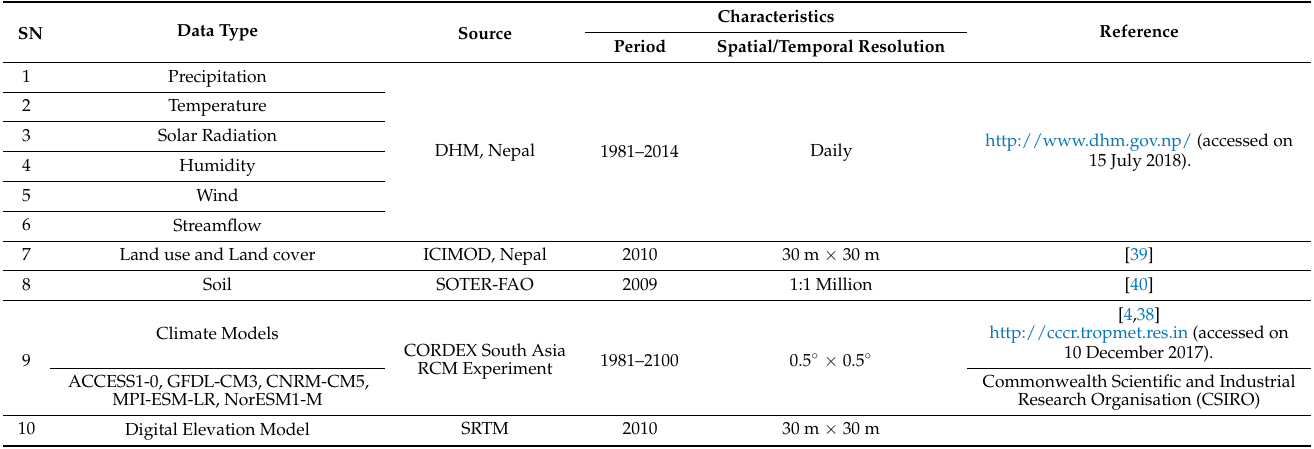
Table 1. Characteristics and spatial extent of different data used in the current